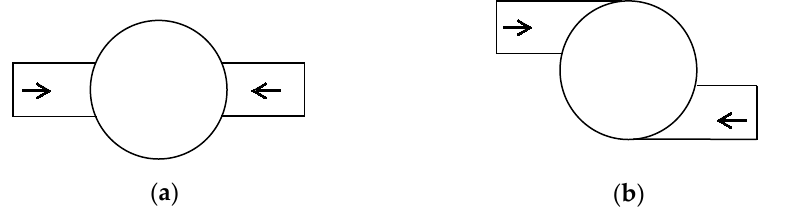
Figure 3. Vertical view of tower with Dual inlet; ( a ) Straight dual inlet; ( b ) Tangential dual inlet.